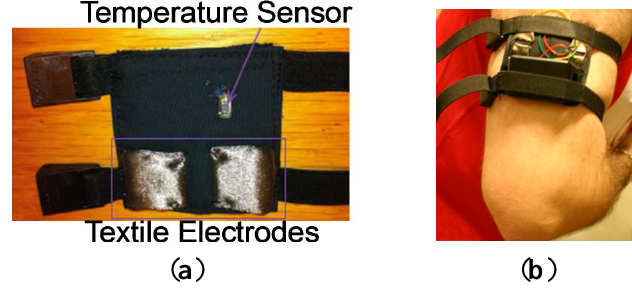
Figure 7. ( a ) Confectioned upper arm strap. ( b ) Measuring device and strap worn on the upper